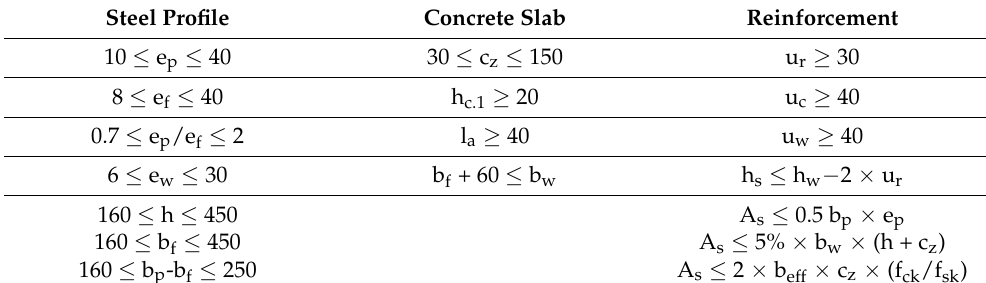
Table 2. Application range—geometric limits for SFB type [21].